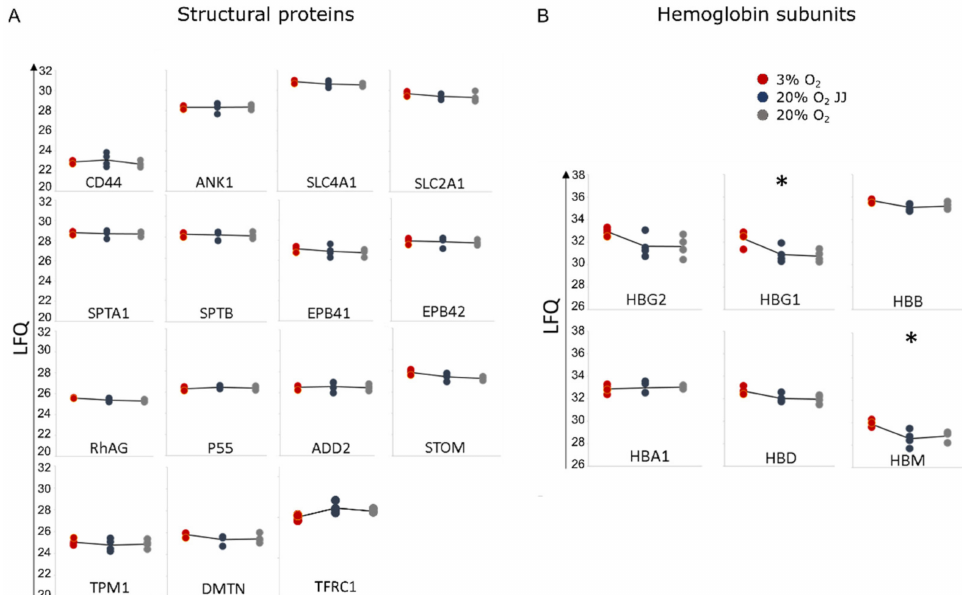
Figure 8. Proteomics data. ( A ) Typical structural proteins for reticulocytes and RBC stability. No significant differences were detected among the three culture conditions. ( B ) Hemoglobin subunits confirm a significantly higher expression of the gamma globin 1 (HBG1) and show a higher expression of hemoglobin subunit mu (HBM). * = p <